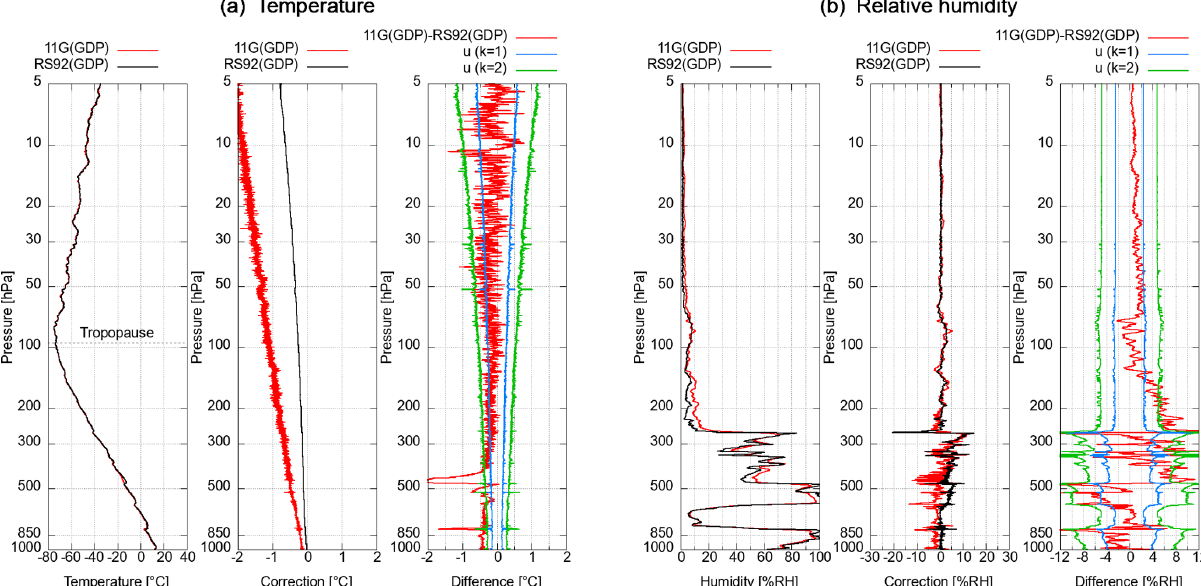
Figure 21. Temperature (a) and RH (b) profiles from the dual flight launched at 08:32 (LST) on 28 October 2016. The panels on the left in (a) and (b) show temperature and RH profiles, respectively, from RS-11G GDP (red) and RS92 GDP (black). The middle panels show the total amount of correction. The panels on the right show differences (RS-11G GDP minus RS92 GDP) (red) and estimated uncertainties for k = 1 in blue and k = 2 in green. RH results for the stratosphere are not discussed here because measurement values for the stratosphere are considered to exceed the limit for reliable measurement.